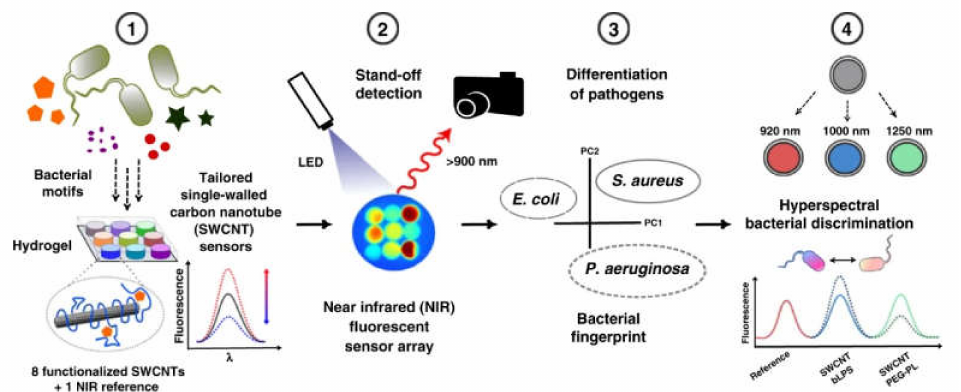
Figure 10. (1) Nanosensors based on near-infrared fluorescent CNTs. (2) Array of eight hydrogel nanosensors and one reference. (3) Bacteria growth changes the sensor array fingerprint, which allows us to differentiate important pathogens. (4) Multiple sensors can be spectrally encoded and used for hyperspectral differentiation of bacteria. Reproduced from Nißler, R. et al. (2020)